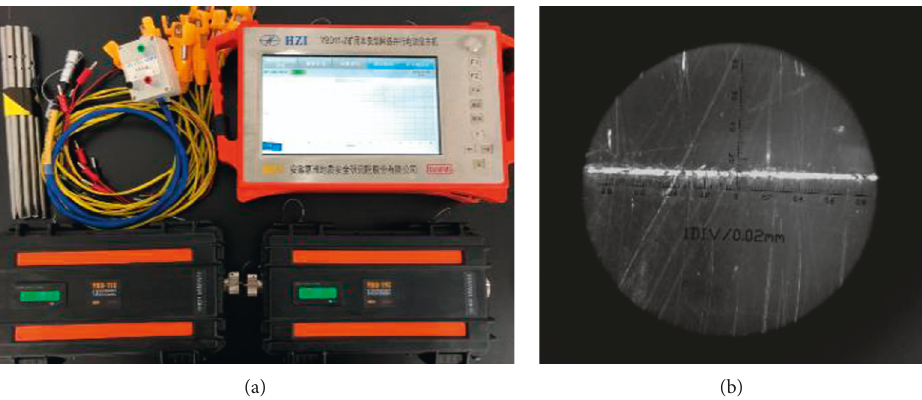
Figure 5: Data acquisition equipment. (a) YBD network parallels electrometer. (b) MG10085-1A 100 reading